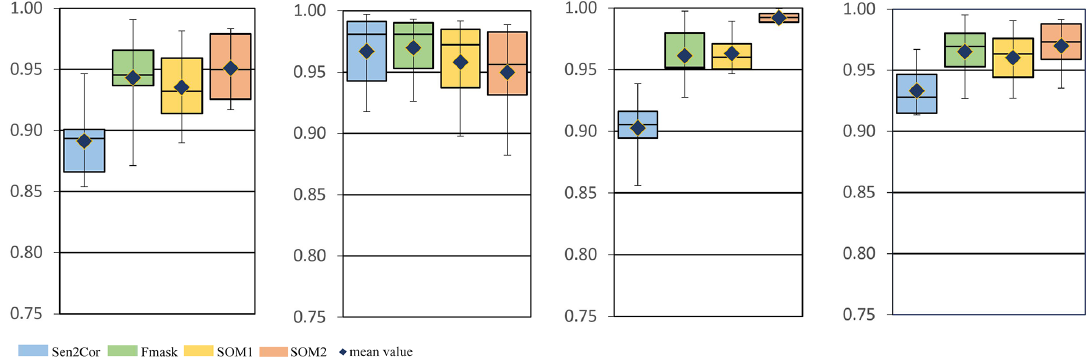
Figure 15. Box plots of the Sentinel-2 images with bright non-cloud